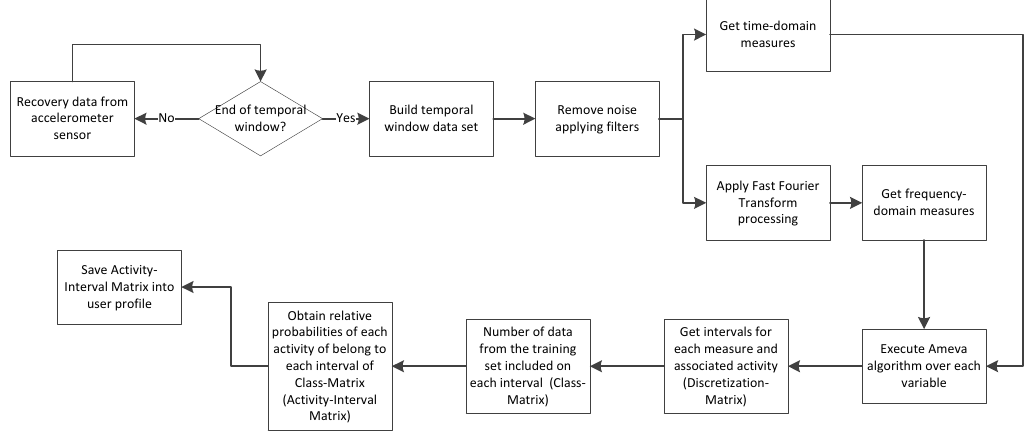
Figure 4. Methodology pipeline for the activity recognition training